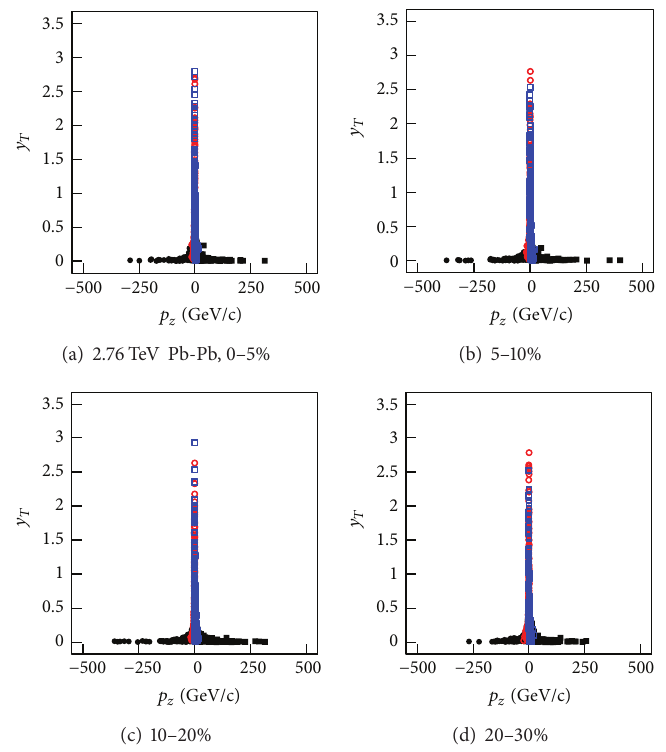
Figure 8: The same as for Figure 4, but showing the results in the space 𝑦 𝑇 − 𝑝 𝑧